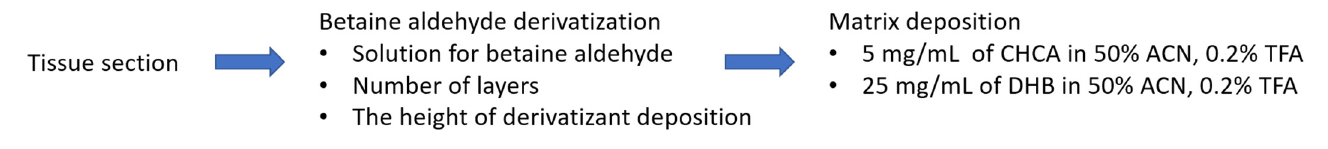
Figure 2. The scheme of sample preparation before MSI analysis with tested alternations .